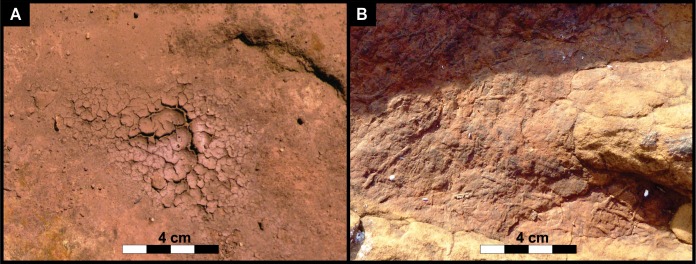
(A) Modern desiccation cracks within a thin, mud layer in the depression of an Lower Jurassic track at the study site. (B) Casts of ancient desiccation cracks that had been preserved inside the Lower Jurassic track.The cracks are comparable in size and shape, having a characteristic hexagonal cracking pattern. The modern example formed after a summer thunderstorm following the evaporation of the muddy storm water from the track depression. The subaerially exposed mud layer cracked up due to dewatering within a few hours. These cracks may then be filled with sandy sediment in subsequent sedimentation events to form similar casts as in tracks #3 and 69.